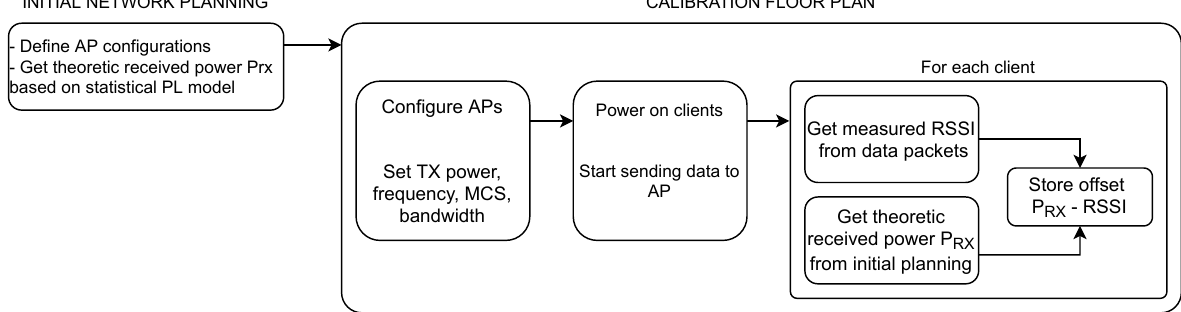
Figure 3. Coverage map calibration algorithm: storing offset between measured received signal strength information (RSSI) and simulated received power (P RX ) for every